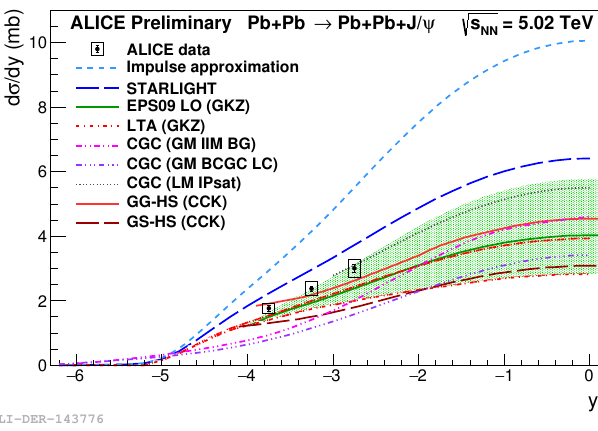
Figure 6. Measured coherent di ff erential cross section of J /ψ photoproduction in ultra-peripheral √ s NN = 5 . 02 TeV. The error bars correspond to the statistical uncertainties, the Pb–Pb collisions at open boxes to the systematic uncertainties. Results from various models are also